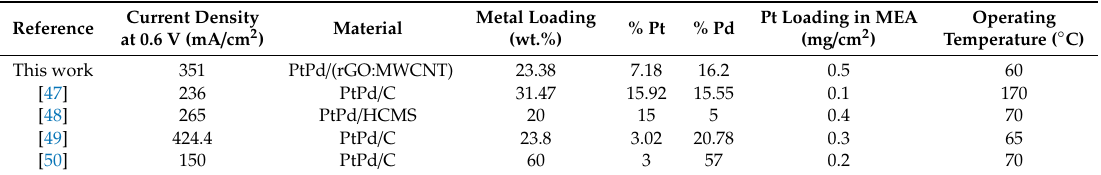
Figure 5. Polarization and power density curves of PtPd / rGO, PtPd / MWCNT, PtPd / (rGO:MWCNT), and (PtPd / rGO) + (PtPd / MWCNT). Table 1. Comparison of Proton Exchange Membrane Fuel Cell (PEMFC) performance of different PtPd materials as cathodes.